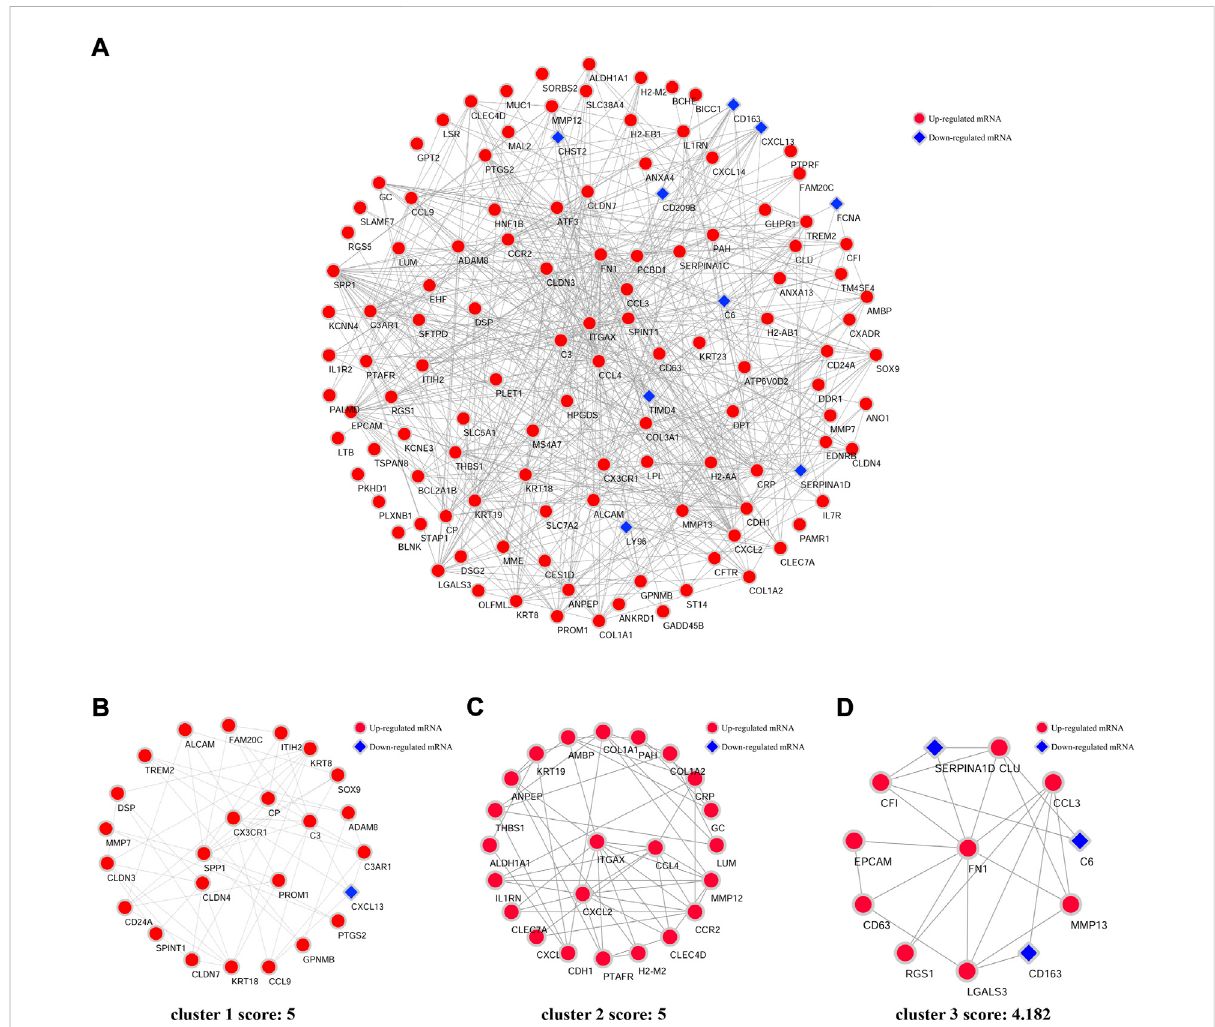
FIGURE 4 PPI network of DEGs and three clusters extracted by MCODE. (A) Using the Cytoscape software and online database STRING, the protein – protein interaction network coded by DEGs comprised 124 nodes and 526 edges. Each node represents a protein, while each edge representstheassociationofproteins.ReddiamondsrepresenttheupregulatedDEGs,andbluehexagonsrepresentthedownregulatedDEGs.Three cluster modules were extracted by MCODE. Cluster 1 (B) had high cluster score (score: 5, 25 nodes and 60 edges), followed by cluster 2 (C) (score: 5, 23 nodes and 55edges), and cluster 3 (D) (score: 4.182, 12 nodes and 23